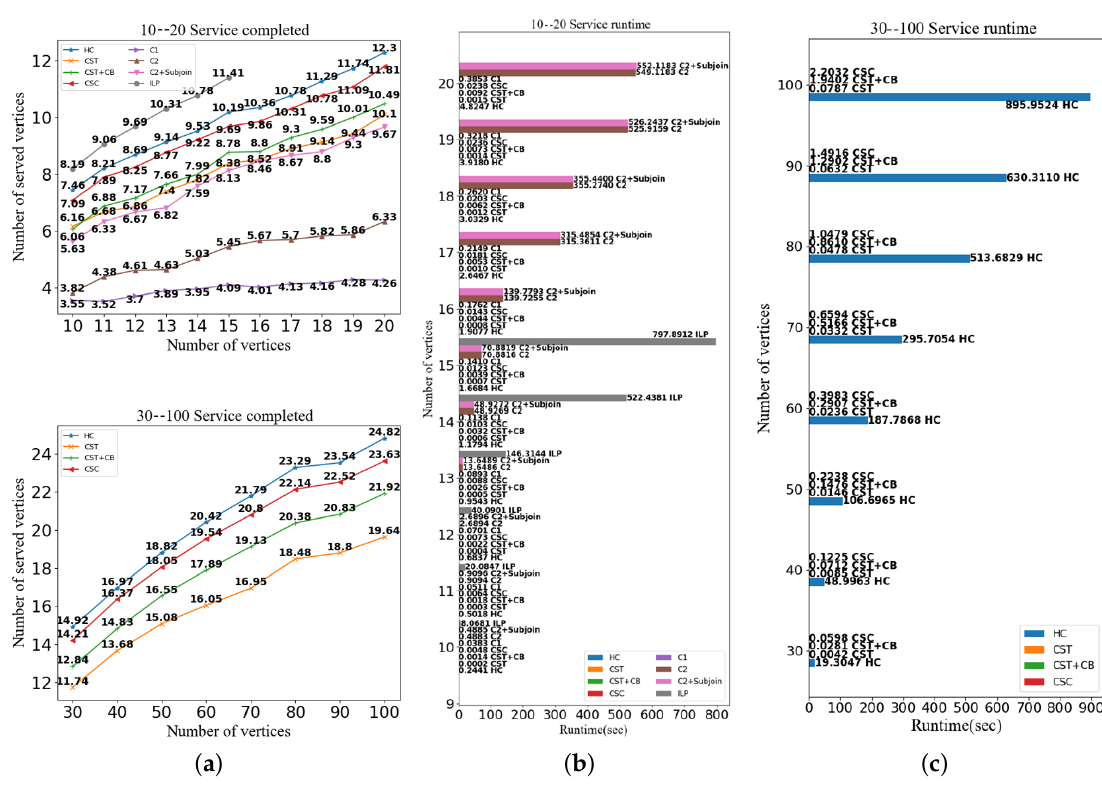
Figure 5. The performance of our approach and baseline algorithms in the 1-principal-1-assistant scenario. Test of the Number of Served Vertices: ( a ); Test of the Running Time: ( b , c